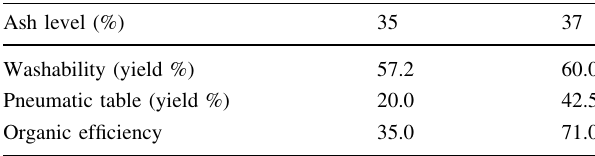
Table 6 Separation performance at different ash levels for single stage